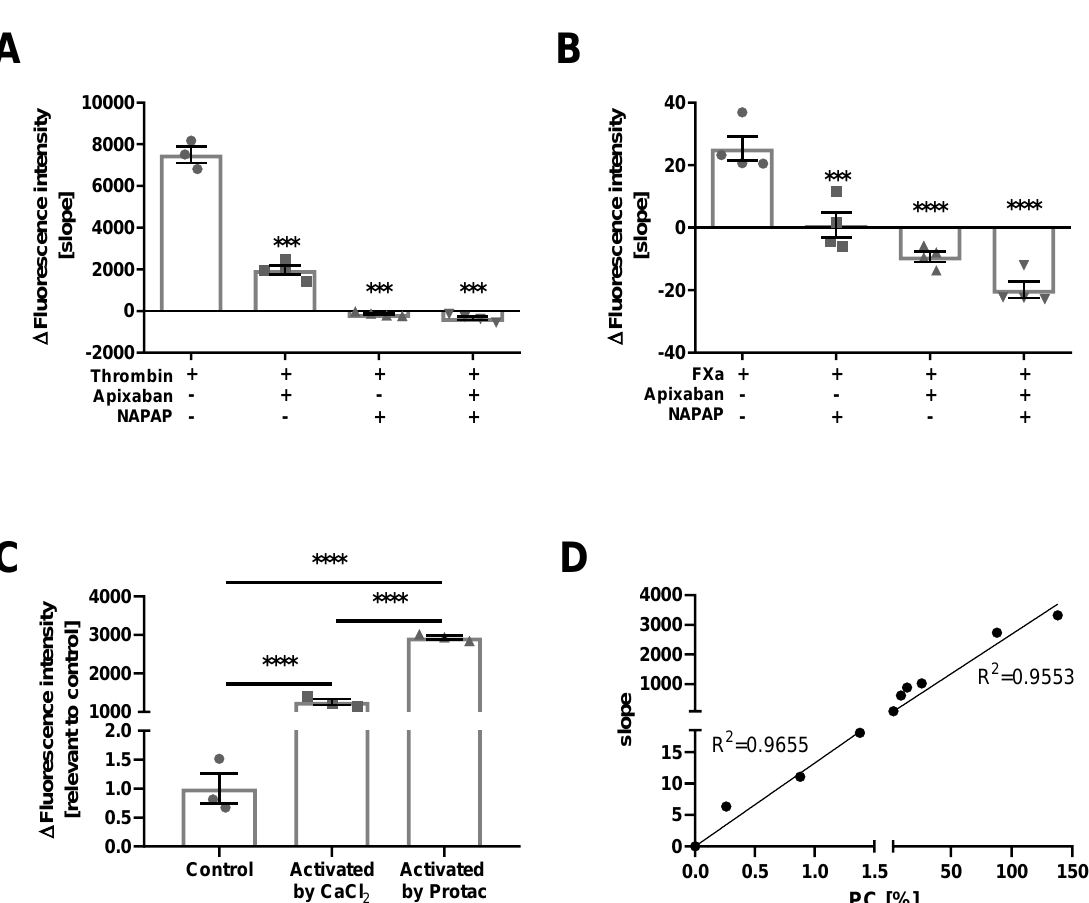
Figure 1. Substrate cleavage and measurement validation. ( A ) substrate cleavage by thrombin: Thrombin (50 mU) cleaves the activated protein C (APC) substrate in a non-APC manner ( n = 3). Apixaban significantly decreases the non-APC substrate cleavage by thrombin ( n = 4, p < 0.0001). alpha-naphthylsulphonylglycyl-4-amidinophenylalanine piperidine (NAPAP) and NAPAP with apixaban completely block the non-APC substrate cleavage by thrombin ( n = 4, p < 0.0001). ( B ) substrate cleavage by FXa: FXa (10 mU) cleaves the APC substrate in a non-APC manner ( n = 4). NAPAP significantly decreases the non-APC substrate cleavage by FXa ( n = 4, p < 0.0005). Apixaban and apixaban with NAPAP completely block the non-APC substrate cleavage by FXa ( n = 4, p <